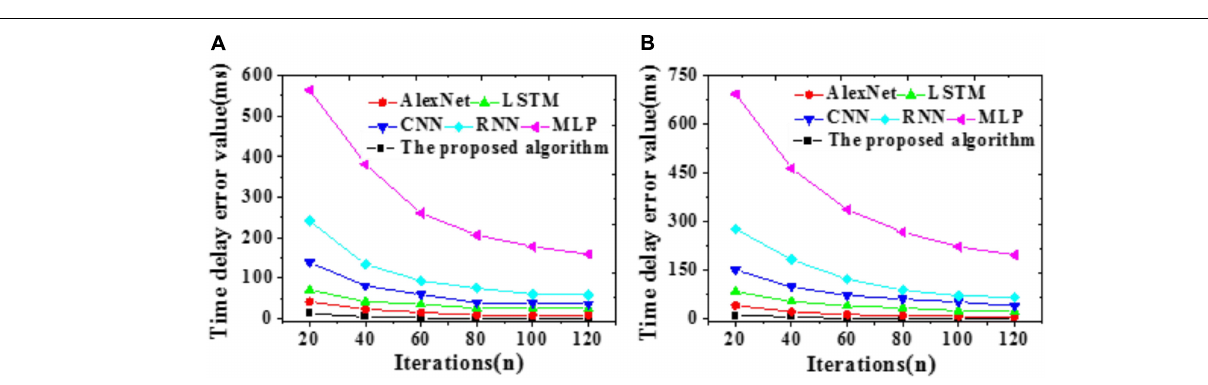
FIGURE 8 | Time delay errors of different models (A) Training set; (B) Test set.